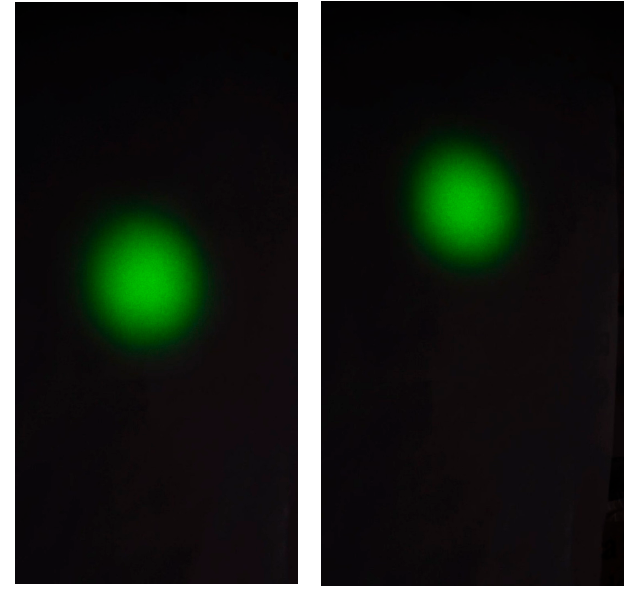
Figure 10. Two frames acquired at the beginning and at the end of the test: after the truck left the bridge, the footprint is higher.